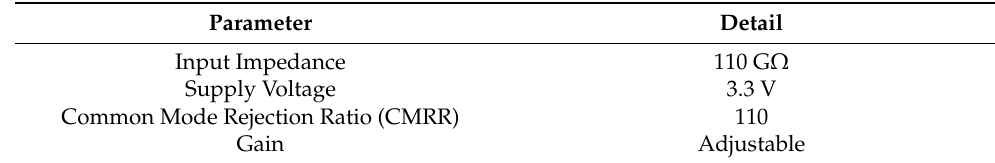
Table 2. Parameters of the Myoware muscle